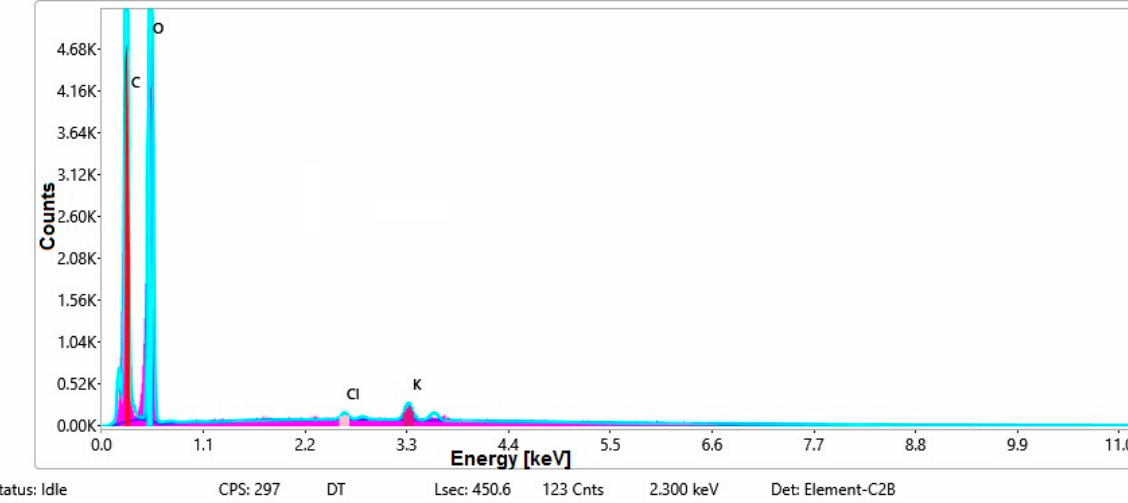
Figure 13. Smart elemental mapping overlay for sample S2 treated in RF plasma O 2 , using RF 1 generator and power 200 W.